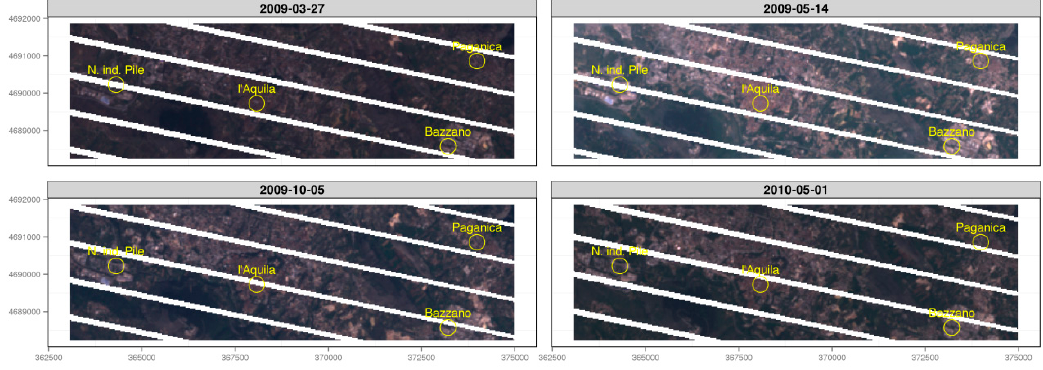
Figure 6. RGB composite of the four image-sets used for Land Surface Temperature estimation Scan Line corrector (SCL)-off mask applied, no cloud cover assessment); images are around 12 km in width.